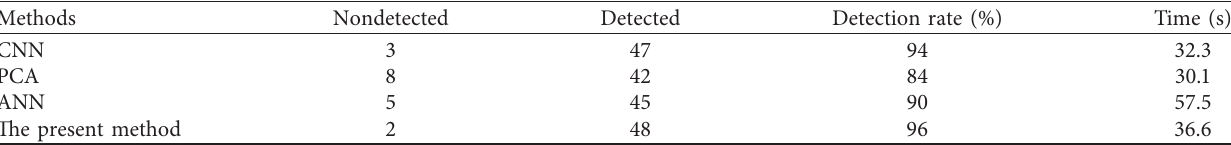
Table 2: Comparison of the three